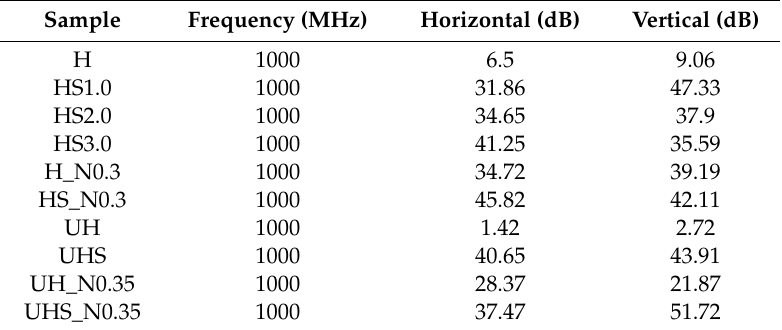
Figure 15. Electromagnetic shielding e ff ectiveness of 180 MPa-HPFRCC. ( a ) Plain; ( b ) 2.0 % steel fiber; ( c ) 0.35% MWCNT; ( d ) 2.0% steel fiber and 0.35% MWCNT. Table 6. SE results at 1